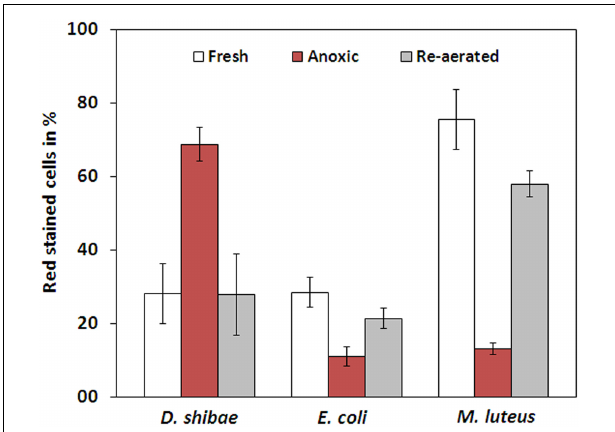
FIGURE 3 | Fraction of red stained cells for fresh, anoxic, and re-aerated cells. D. shibae has 2.5-fold more red stained cells during anoxia, compared to fresh cells and after re-aeration. E. coli has 2.5-fold and M. luteus even 5-fold less red stained cells during anoxia. All strains approach their original value after re-aeration.